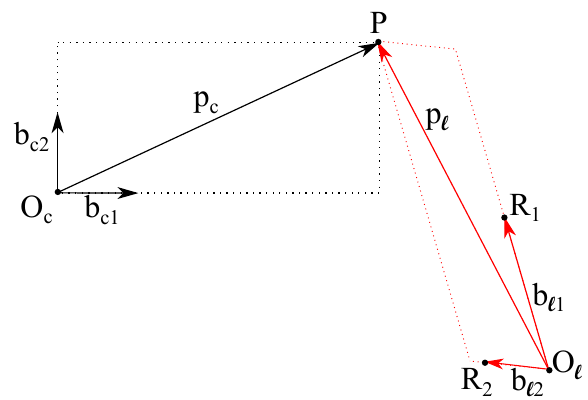
Figure 1: Representing a point P in the canonical coordinate sys- tem (black) and a local coordinate system